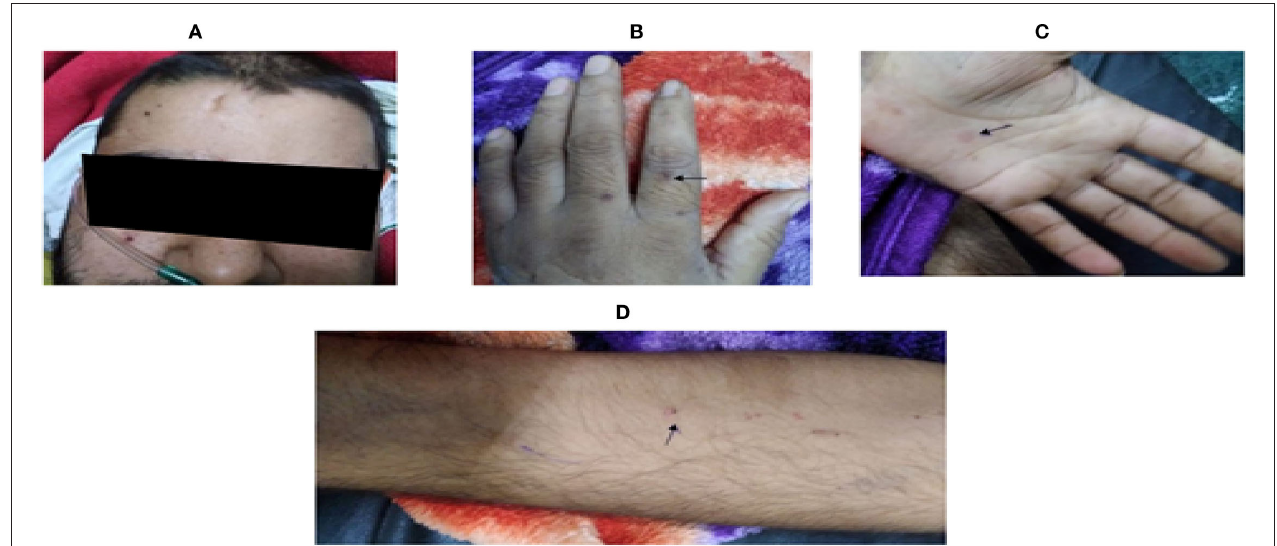
FIGURE 2 | Showing skin lesions observed on eleventh day of hospital stay. (Arrow): Multiple, erythematous, and non-palpable maculopapular lesions over (A) face, (B,C) palm and dorsum of both hands, and (D) flexor aspect of